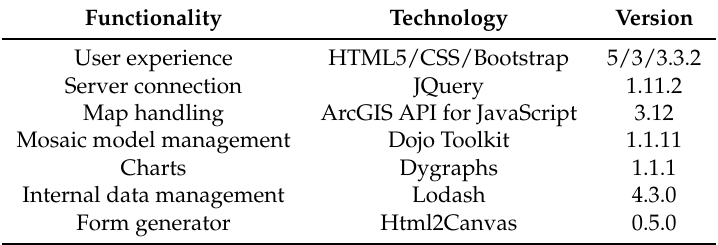
Table 2. Technologies and libraries for the implementation of the front-end of the regional geoportal.